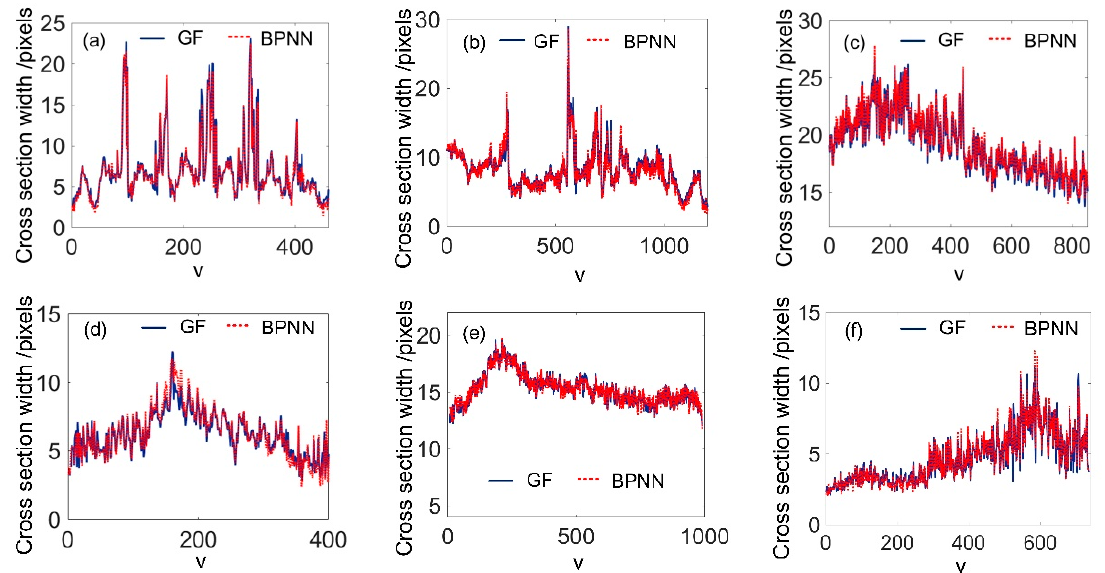
Figure 10. Comparison of the cross section width values by GF and BPNN, ( a – f ) correspond to the stripes of the ROI in Figure 9a–f. Table 1. Comparison of Gaussian fitting (GF) method with the back propagation neural network (BPNN) method.